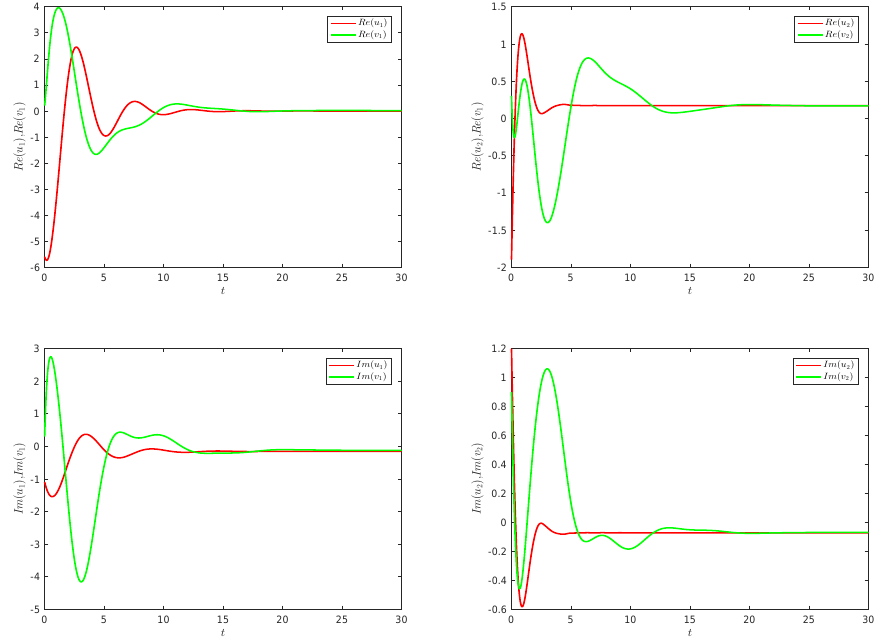
Figure 4. The curves of states u ( t ) and its estimation v ( t ) in Example 2.